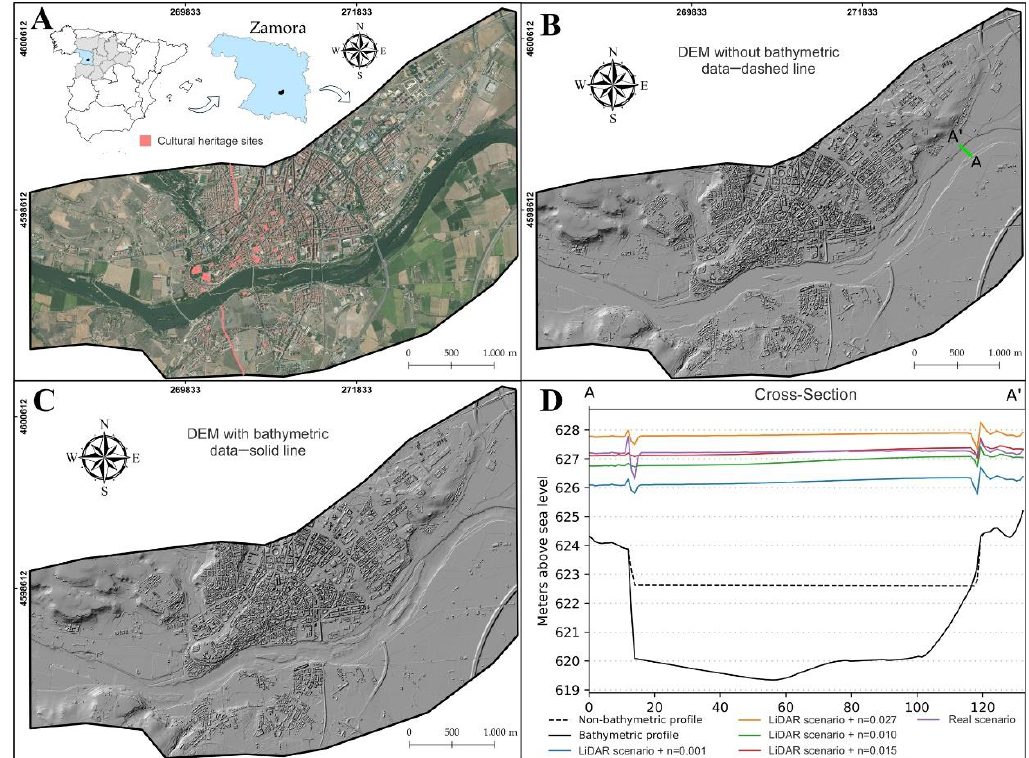
Figure 1. The study area and cultural heritage sites location map ( A ). The digital elevation model (DEM) from LiDAR data ( B ) not showing bathymetry, which was included from echo sounders with a D-GPS ( C ). Example of a cross-section flow depth calibration ( D ).